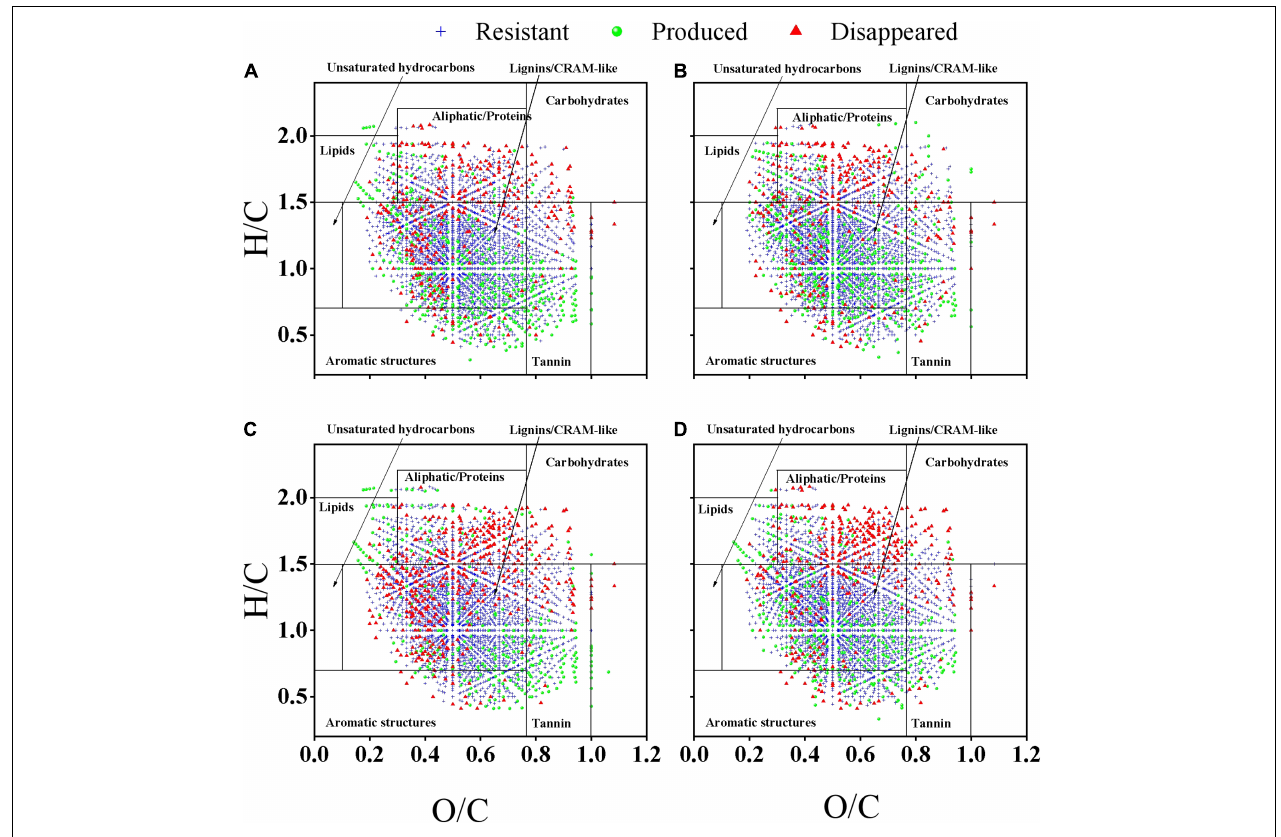
FIGURE 4 | van Krevelen diagrams of the changes in biochemical compound classes of soil DOM between different stand ages of Chinese fir plantation. (A) A comparison between 4- and 15-year-old sites. (B) A comparison between 4- and 24-year-old sites. (C) A comparison between 4- and 43-year-old sites. (D) A comparison between 4- and 100-year-old sites. Points in red represent DOM molecules that disappeared with stand development, points in blue represent unchanged DOM molecules, and points in green represent new molecules that appeared during stand